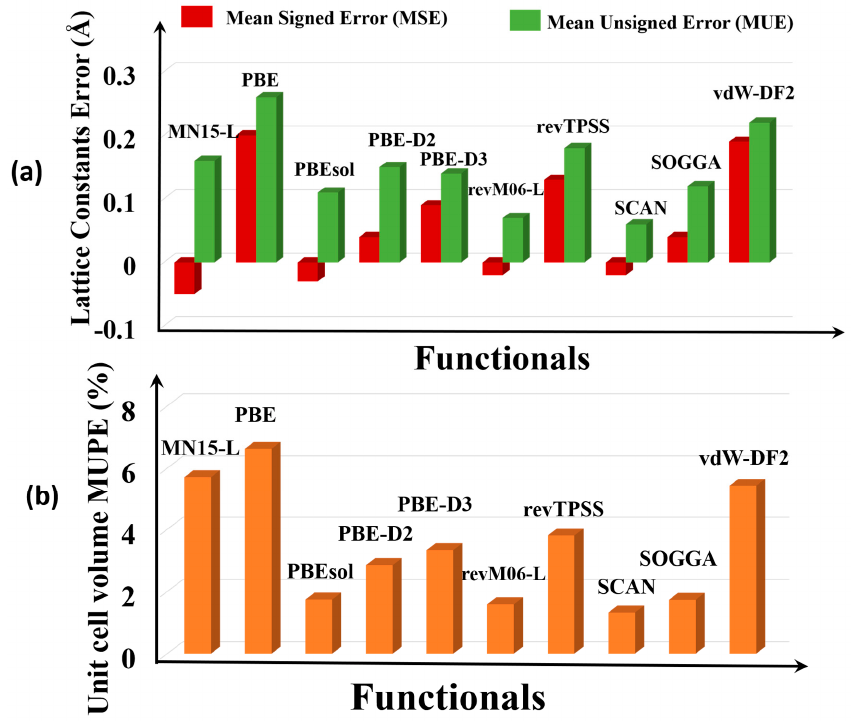
Figure 2. Errors in ( a ) lattice constants and ( b ) unit cell volumes.